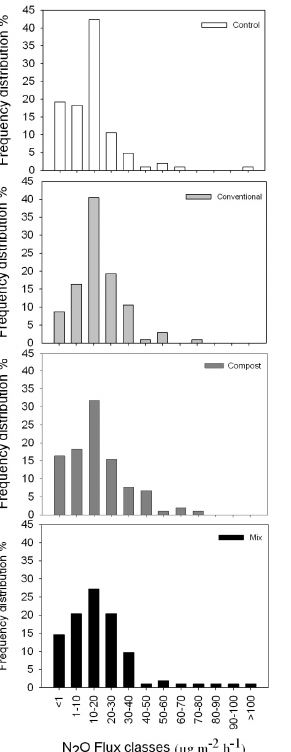
Figure 3. N 2 O hourly flux (A) and cumulative flux (B) measured in the plots of the four treatments between 13 May and 25 July 2013. DAF stands for days after fertilization event (13 May 2013). Error bars represent one standard deviation (n = 8). Dotted lines represent the fertilization event (1st line) and the first crop harvesting (2nd line).